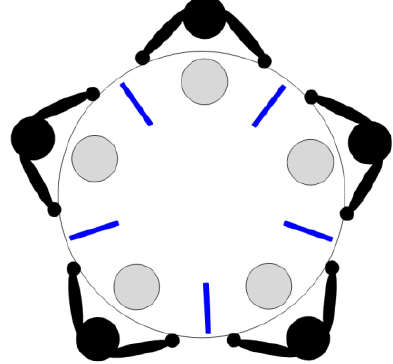
Fig. 1. Dining Chinese